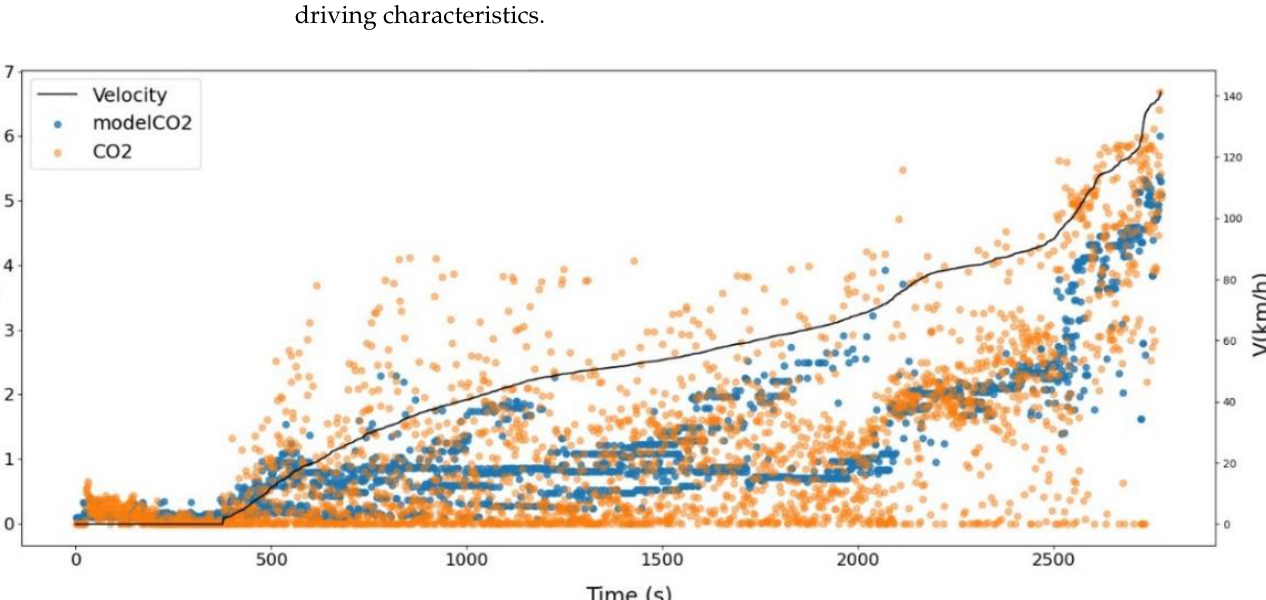
Figure 8. Predicted vs. observed CO 2 emission from LPG vehicle.